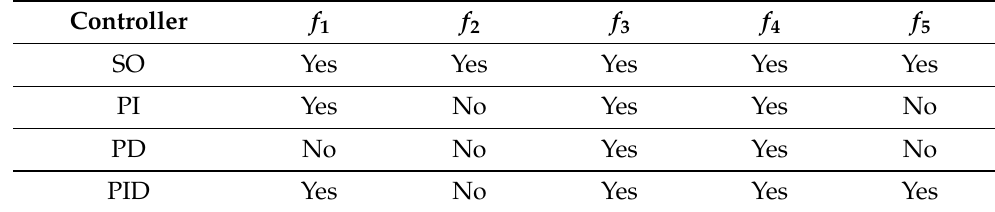
Table 1. Compact fuzzy controller f i